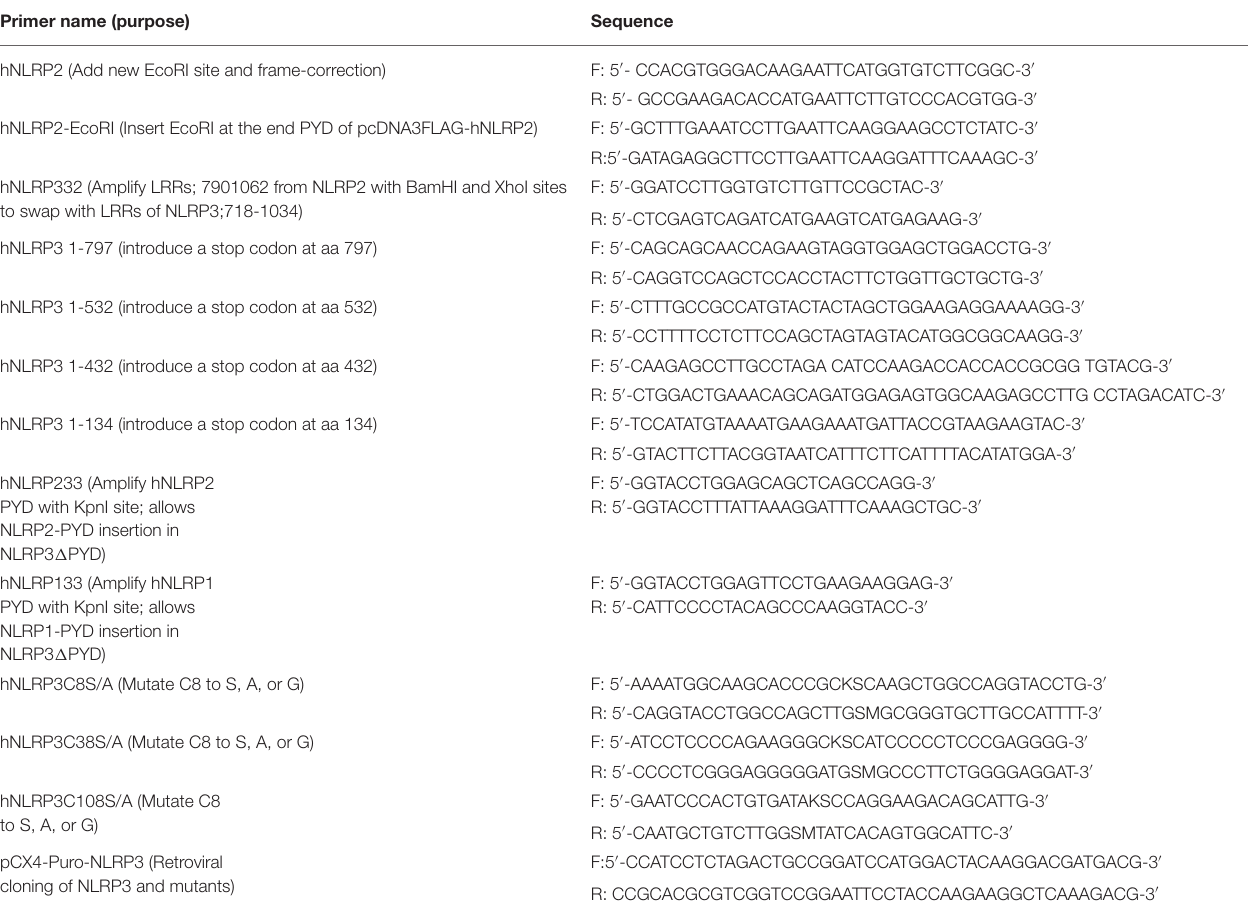
TABLE 1 | Primers Used in the